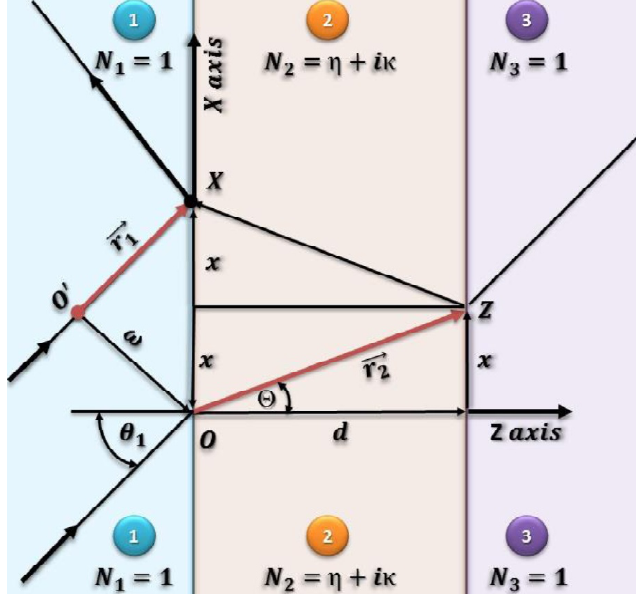
Fig. 4. The ray that is reflected in X and reflected from the back surface in medium 2 used to calculate 